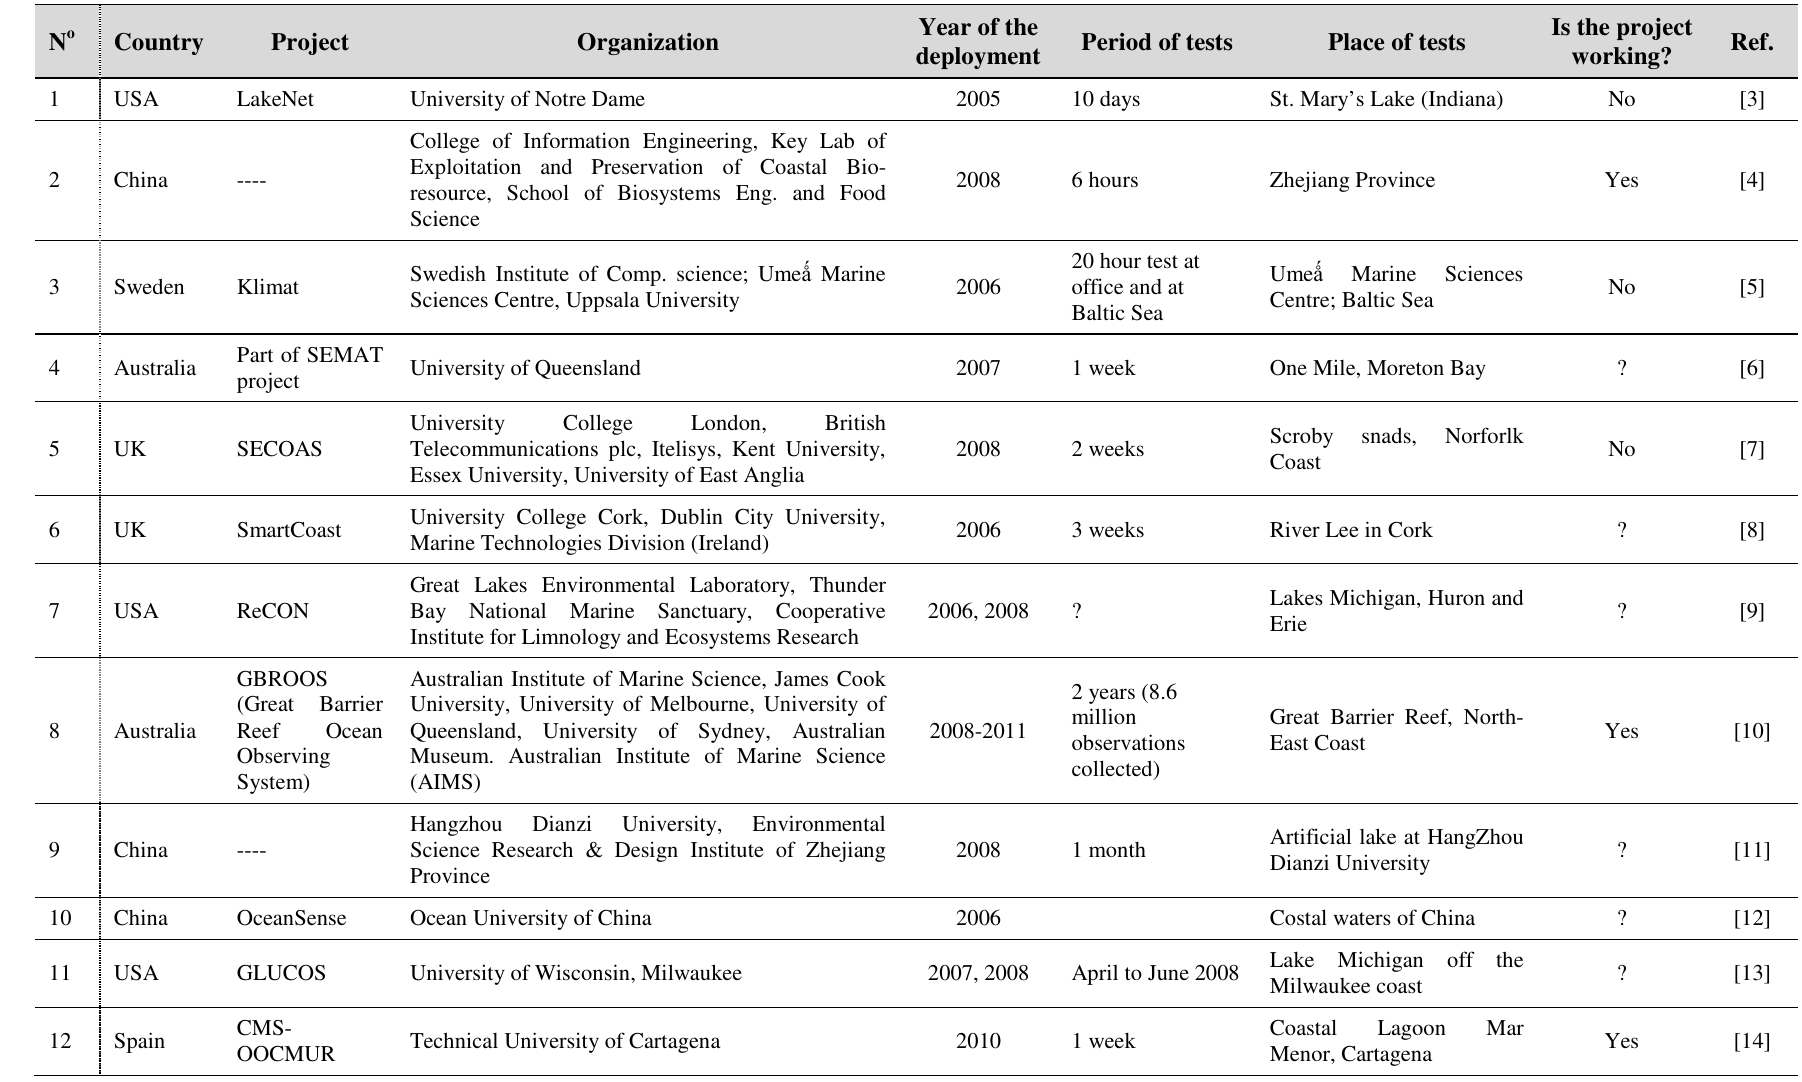
Table 4. Systematic review results: Organizational